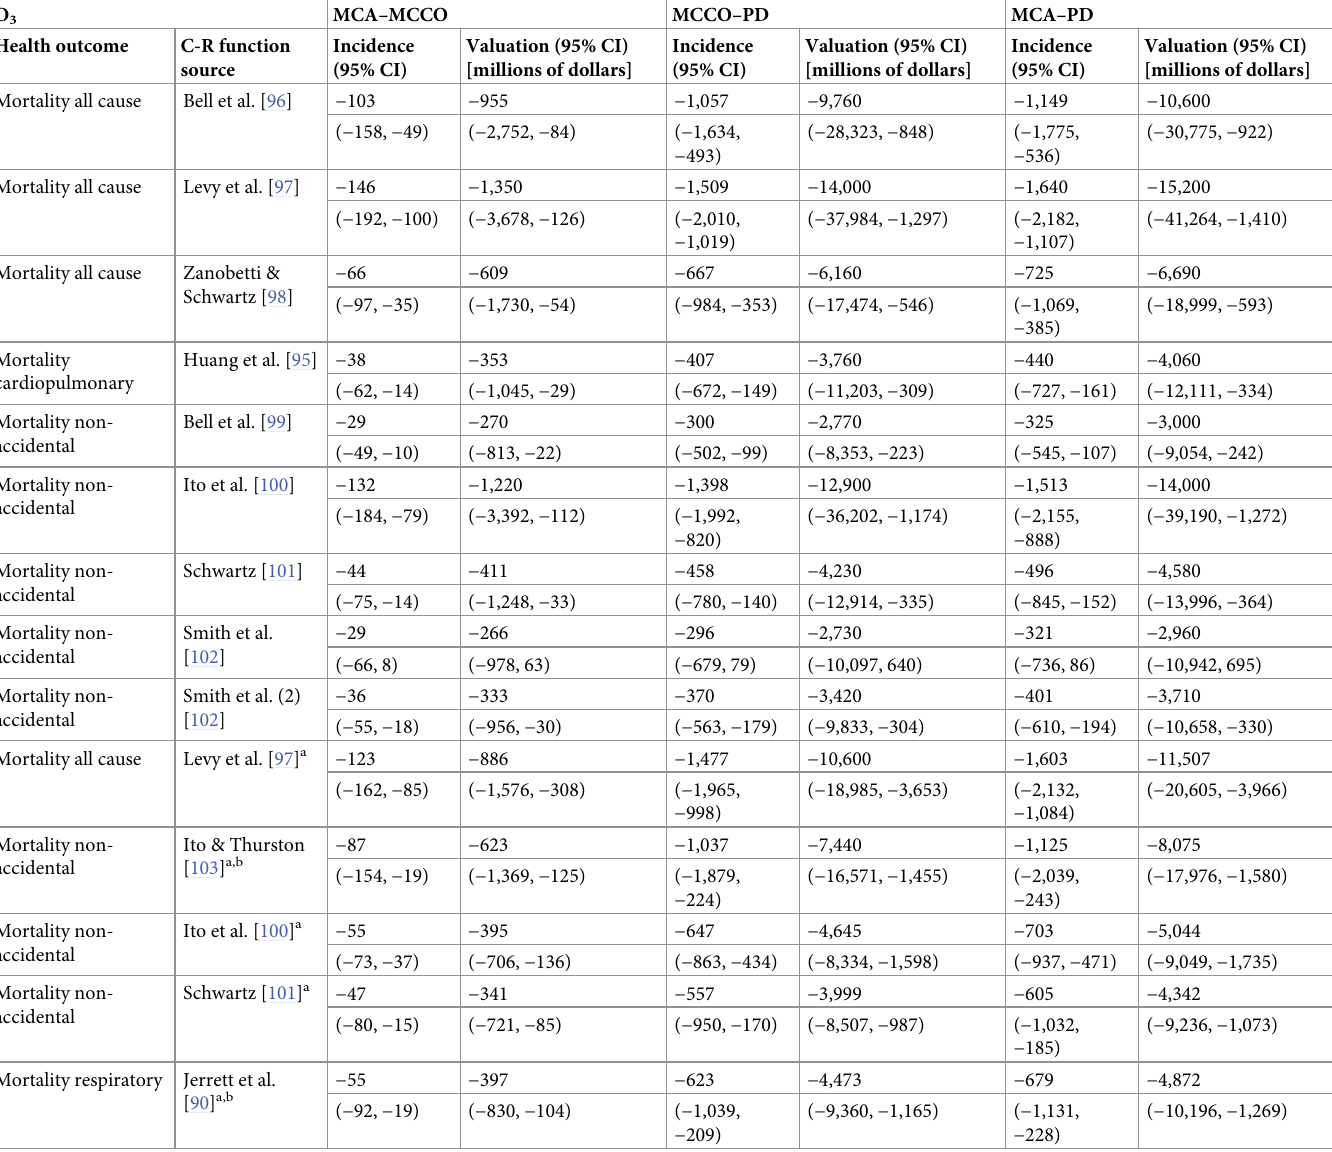
Table 3. O 3 -related mortality results summed regionally for July exposure and displayed for each scenario comparison. O